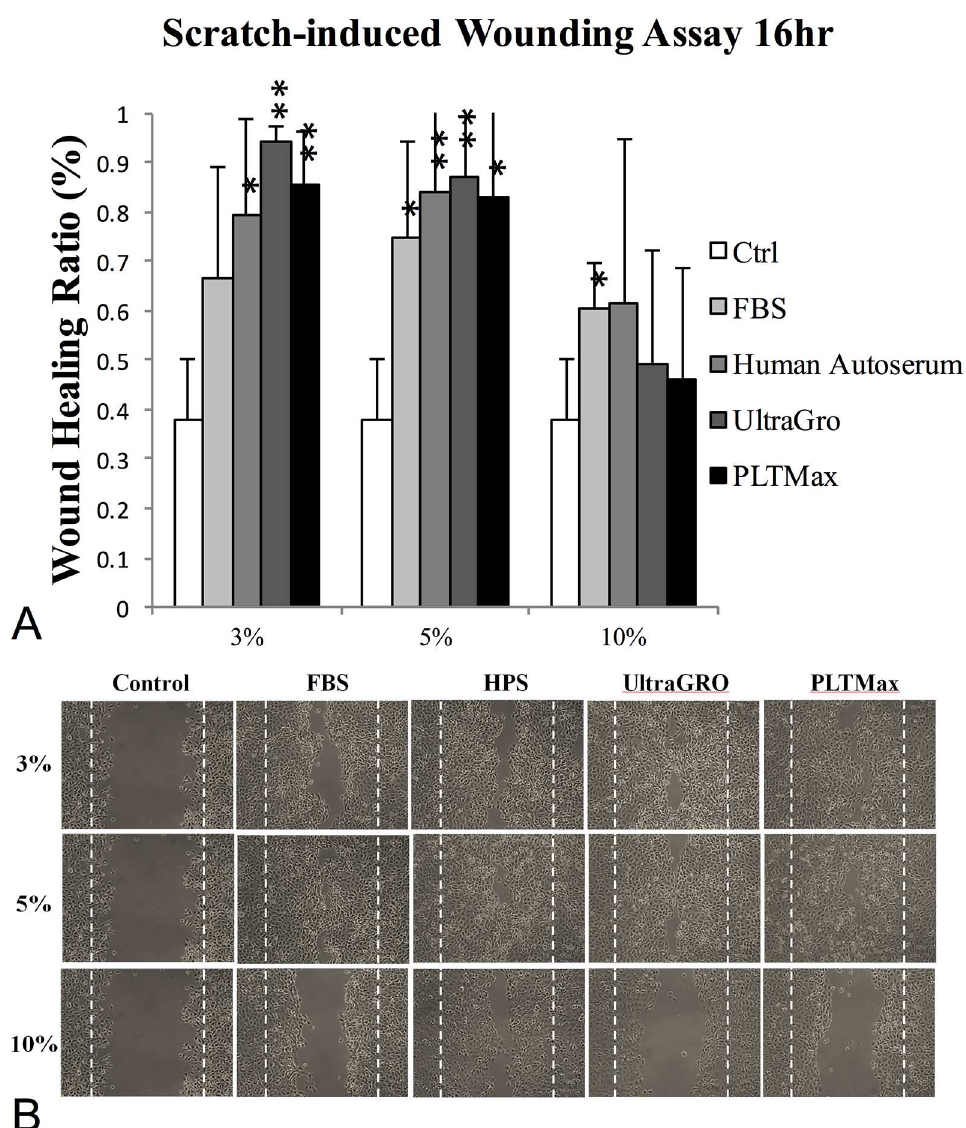
Fig 1. Cell migration: Scratch-induced directional wounding assay at 16 hours after wounding. (A) 10% preparations of blood derivatives demonstrated poorer responsecomparedto 3% and 5% preparations. There was no significantdifference amongthe 4 blood derivatives in 3% and 5% preparations. * indicated p < 0.05. ** indicated p < 0.01 comparedto the control group that was without blood derivativesin culture media. (B) Representative picture of the effects of different blood derivatives on epithelialscratch woundhealingat 16 hours after wounding. FBS: fetal bovineserum, HPS: humanperipheral serum. UltraGRO: Human platelet lysate from Helios pharmaceutical. PLTMax: Human platelet lysate from Mill Creek pharmaceutical.